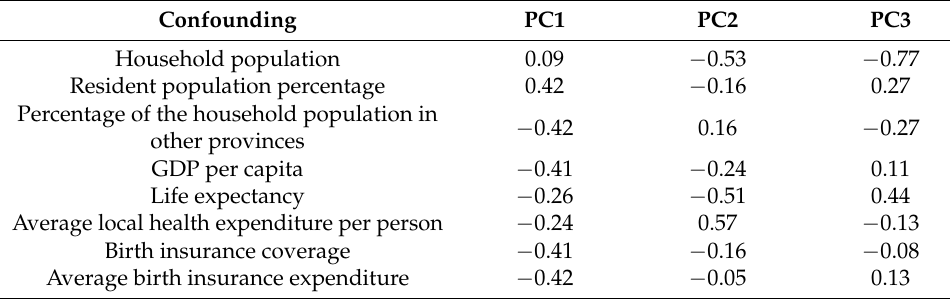
Figure 7. The proportion of variance explained by each principal component. Table 1. The variable loadings for each principal component.